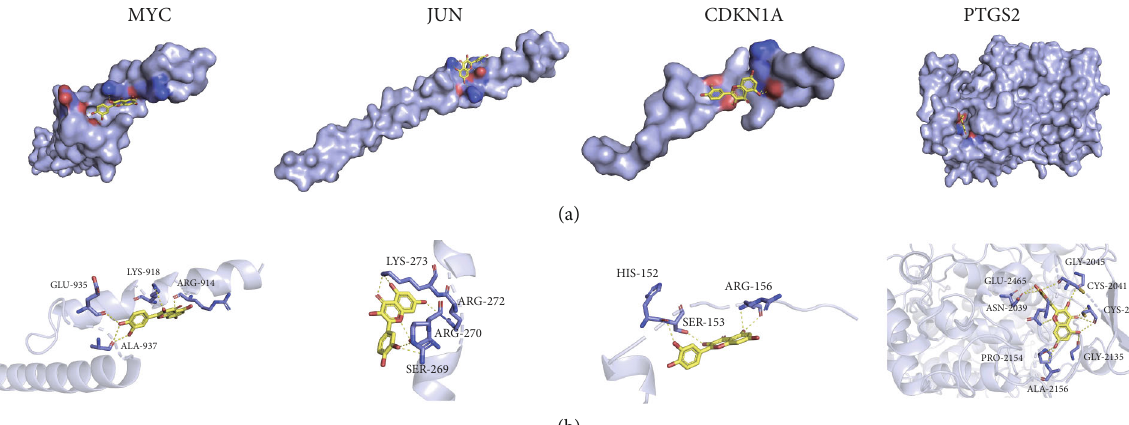
Figure 8: Molecular docking results of quercetin and the hub target genes. (a) The 3D structure of the molecular docking. (b) The hydrogen bond interactions of the molecular docking.